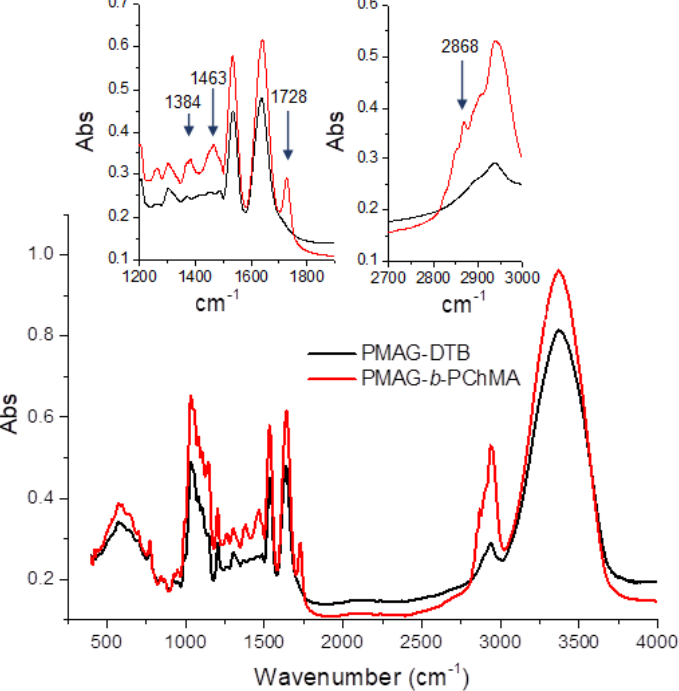
Figure 2. FTIR spectra of PMAG-DTB and its copolymer with